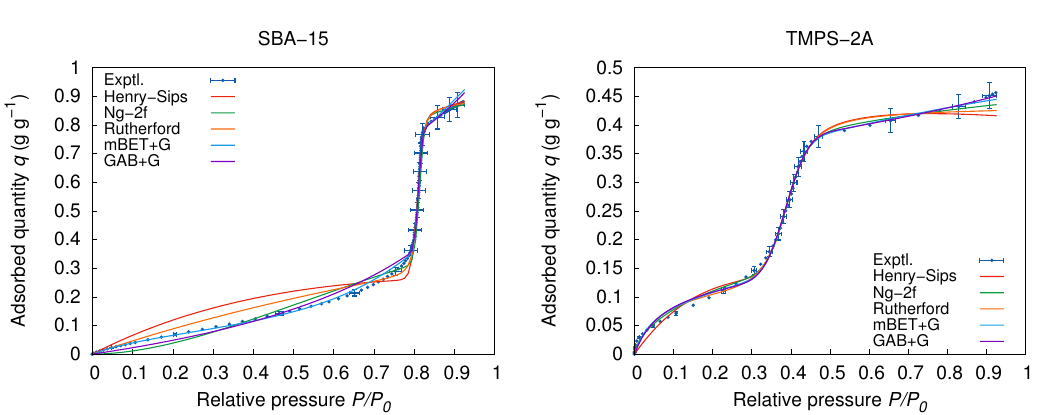
Figure 3. Examples of model fitting on Type IV (TMPS-2A: 25 ◦ C) and Type V (SBA-15: 20 ◦ C) isotherms. Table 3. Statistical coefficients overview (ARD% and χ 2 ) of Henry–Sips, Ng-2f, Rutherford, mBET+G and GAB+G models for all samples at 25 ◦ C (20 ◦ C for SBA-15 and MCM-41).